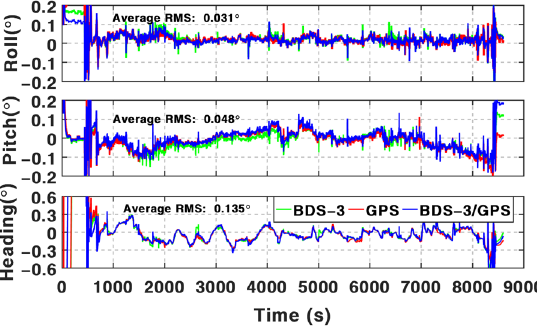
Figure 22. Attitude errors of undifferenced PPP/INS/ODO TCI with different GNSS.